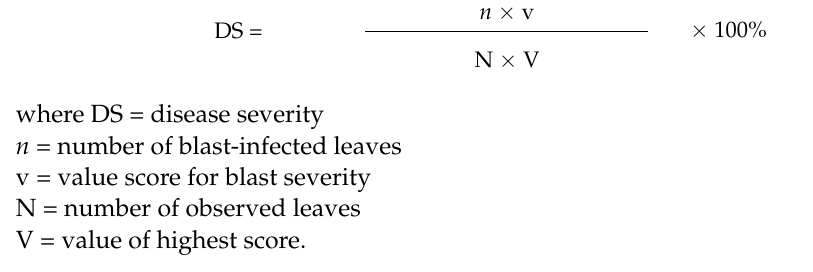
Figure 8. Structures of bonactin ( A ) and feigrisolide C ( B